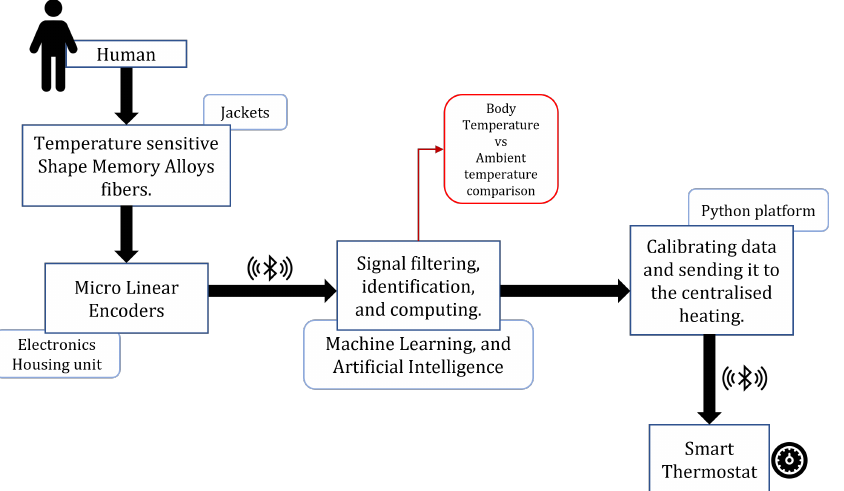
Figure 7. Algorithm for the HCI use case framework. The Machine Learning algorithm is essential to analyze and optimize the thermostat, especially in the multi-user